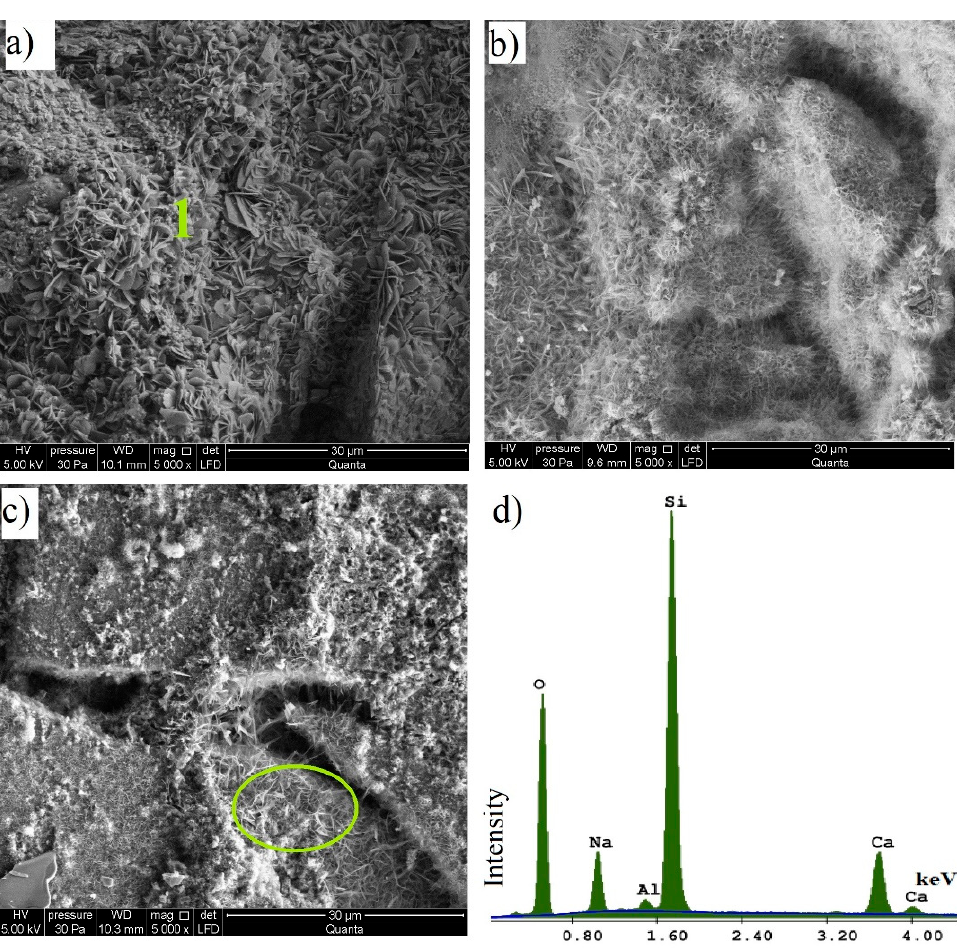
Figure 9. Microstructure of samples ( a ) WG, ( b ) BG, ( c ) GG, and ( d ) EDS analysis at point 1 in ( a ).